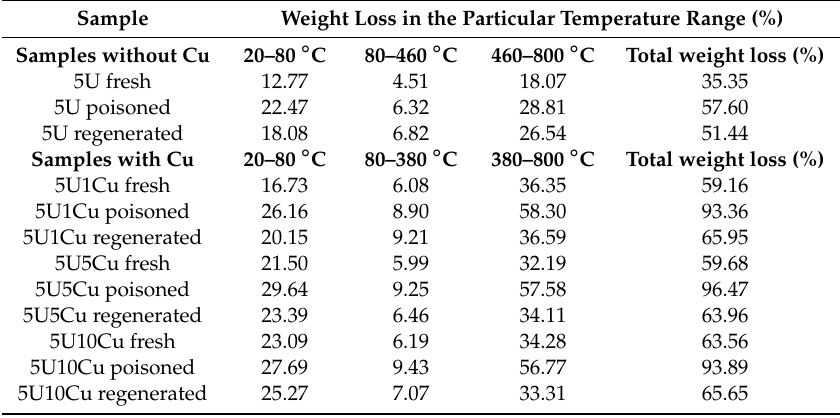
Figure 2. Fourier transform infrared spectra of fresh, poisoned and regenerated: ( A ) 5U; ( B ) 5U1Cu; ( C ) 5U5Cu; ( D ) 5U10Cu. Table 3. Weight loss of the samples during thermogravimetric analysis (TGA) in the particular temperature